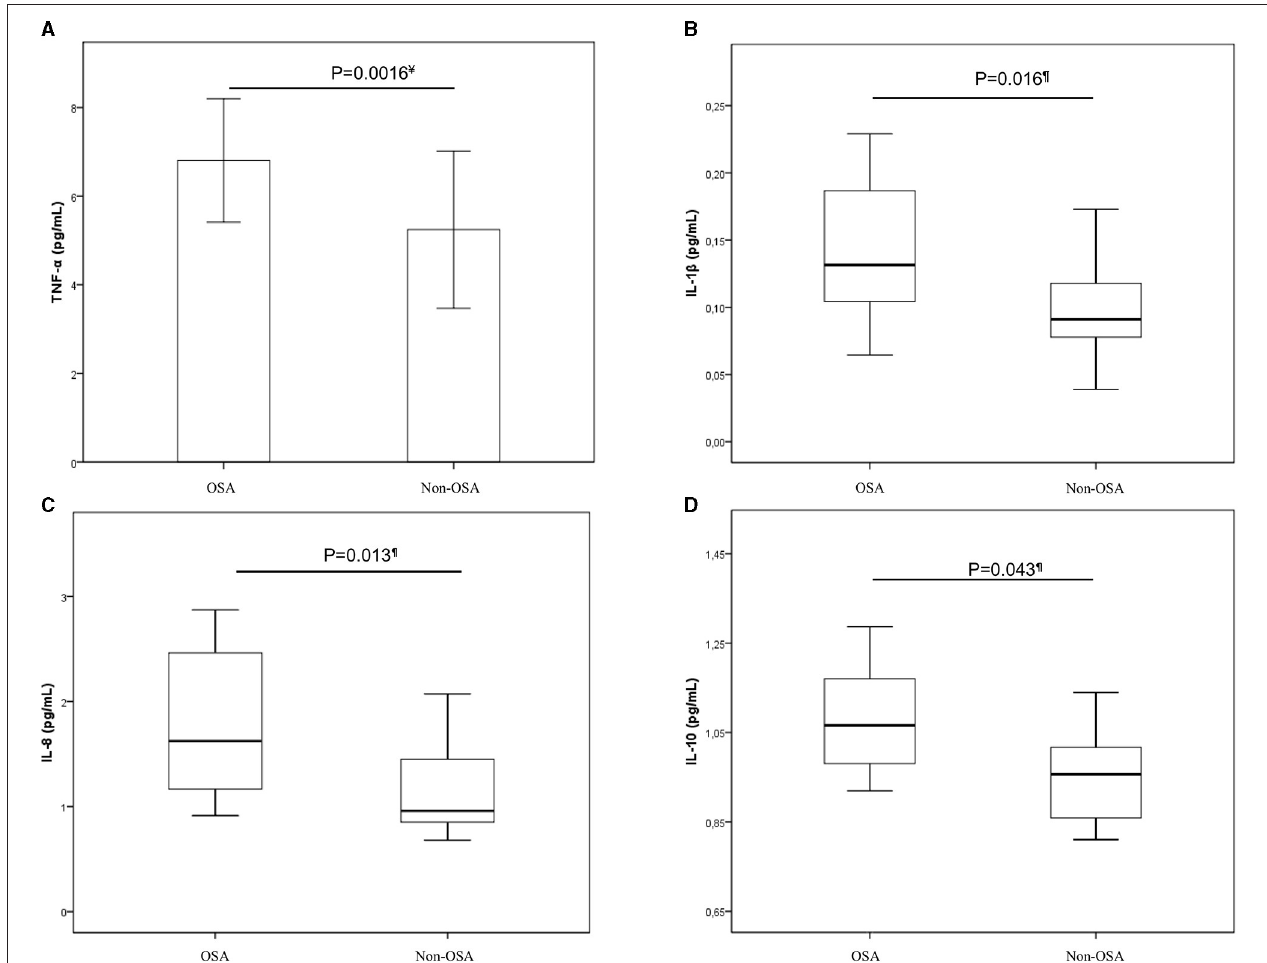
FIGURE 1 | Comparison of cytokines levels in OSA and non-OSA pregnant women. Comparison of cytokines levels in OSA and non-OSA pregnant women. Statistical tests: t -Student U ; U Mann- Whitney ¶ . (A) TNF- α U ; (B) IL-1 β ¶ ; (C) IL-8 ¶ ; (D) IL-10 ¶ . The bar chart represents mean and standard deviation (TNF- α ) and boxplots represent medians and interquartile ranges (IL-1 β , IL-8, and IL-10). IL, interleukin; OSA, Obstructive sleep apnea; TNF- α , Tumor necrosis factor